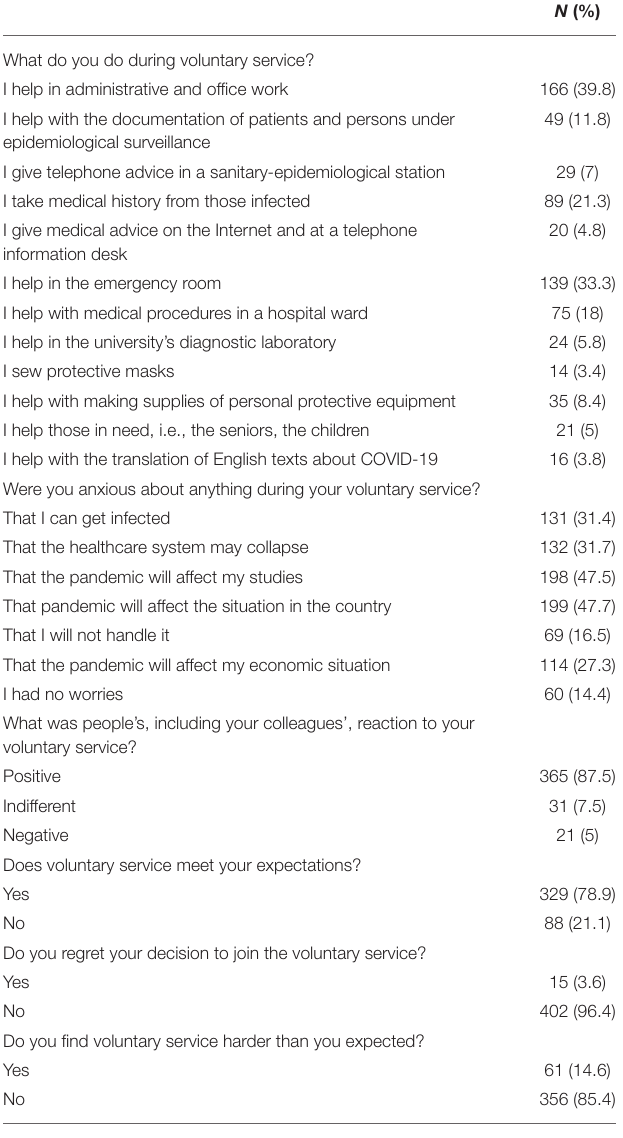
TABLE 4 | Reasons of students’ involvement in voluntary service during the COVID-19 N (%)